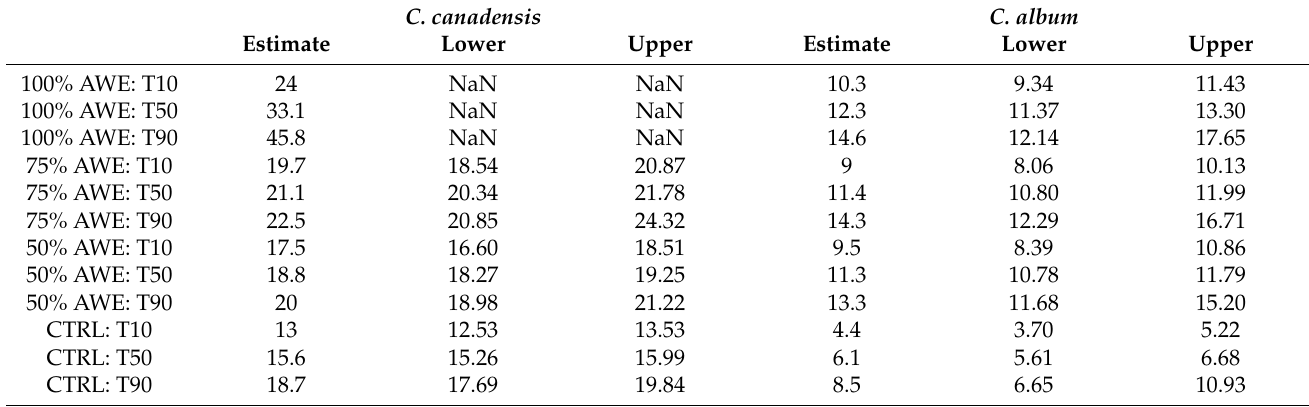
Table 2. Estimated times of germination (10-percentile (T10), median (T50) and 90–percentile (T90)) and their bounds (Lower-Upper) for Conyza canadensis L., Chenopodium album L., Lolium perenne L., Amaranthus retroflexus L. under AWE treatments (50% AWE, 75% AWE, 100% AWE) and control